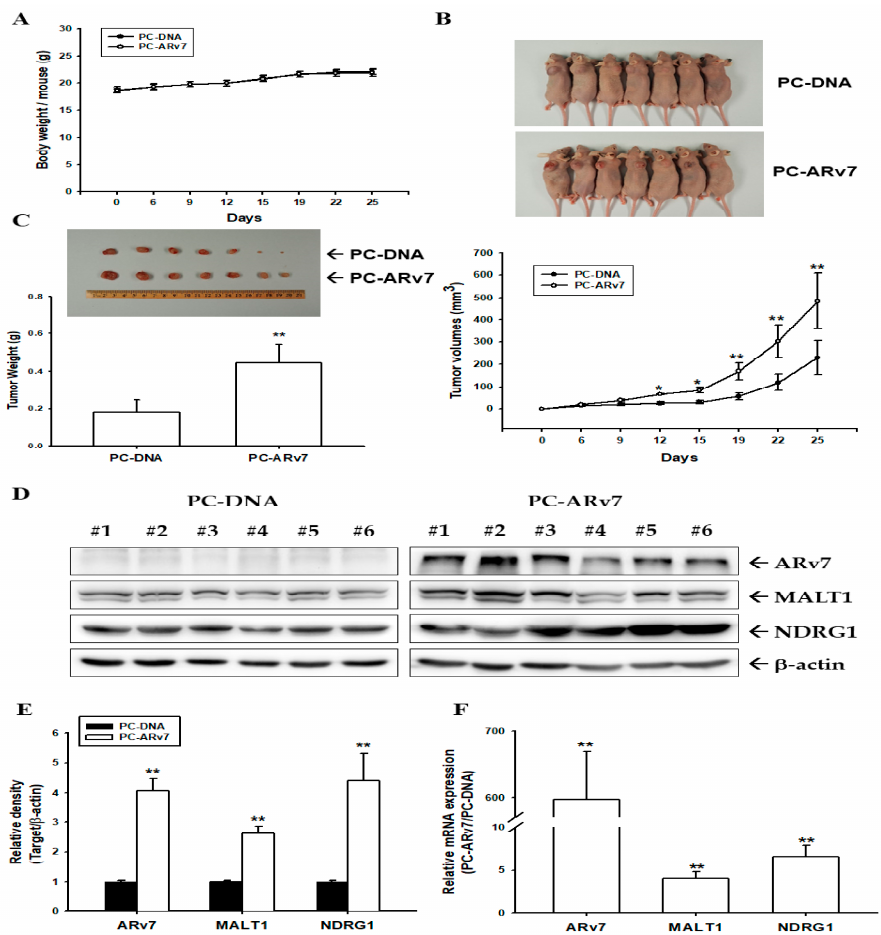
Figure 7. Ectopic overexpression of ARv7 enhances tumorigenesis of PC-3 cells in xenograft mice models. The athymic male nude mice were subcutaneously injected with mock-overexpressed (PC-DNA) or ectopic-overexpressed ARv7 (PC-ARv7) cells for 25 days. ( A ) The average body weight (mean ± SE) of the mice during the experimental period. Photograph of the representative xenografted mice and tumors ( B , top ) and tumor sizes ( B , bottom ), which were measured every 3 days. The mice were sacrificed on the 25th day and the tumors were excised. ( C ) The quantitative data (mean ± SE) of the tumor weight of the PC-DNA and PC-ARv7 groups. ( D ) Whole-cell lysates of tumor samples from the PC-DNA and PC-ARv7 groups were subjected to immunoblot assays for ARv7, MALT1, NDRG1, and β -actin. ( E ) The quantitative data of the immunoblot assays are presented as the mean fold induction of ARv7, MALT1, and NDRG1 relative to the PC-DNA group. ( F ) The mRNA levels of ARv7, MALT1, and NDRG1 in the xenografted tumors were analyzed by RT-qPCR assays ( ± SE, n = 3). * p < 0.05, ** p <